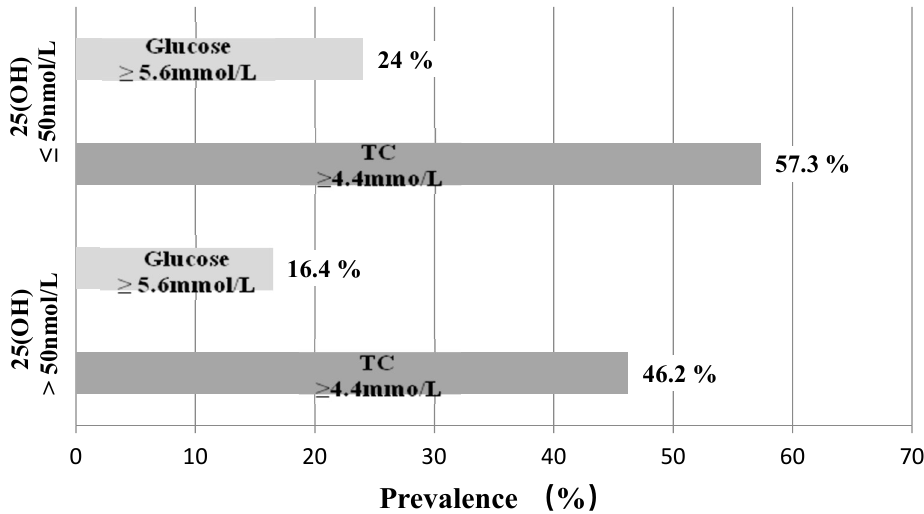
Figure 1. Occurrence of hyperglycemia/hypercholesterolemia in vitamin D-deficient children. TC: total cholesterol